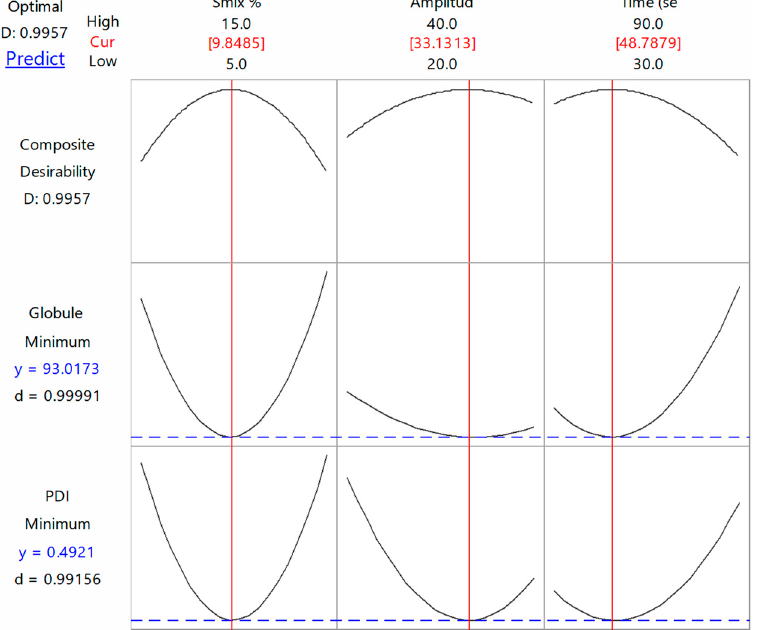
Figure 3. Optimization Box–Behnken design plot of ADS and PDI. Red line designates the present factor settings. Blue line designates the response to the present settings. Composite desirability value (D) approaching one indicates the settings seem to achieve satisfactory responses for all responses. The individual desirability value (d) indicates the value near to one thereby optimizing the settings for each individual response. The upper middle numbers (red) indicate the current optimum settings.